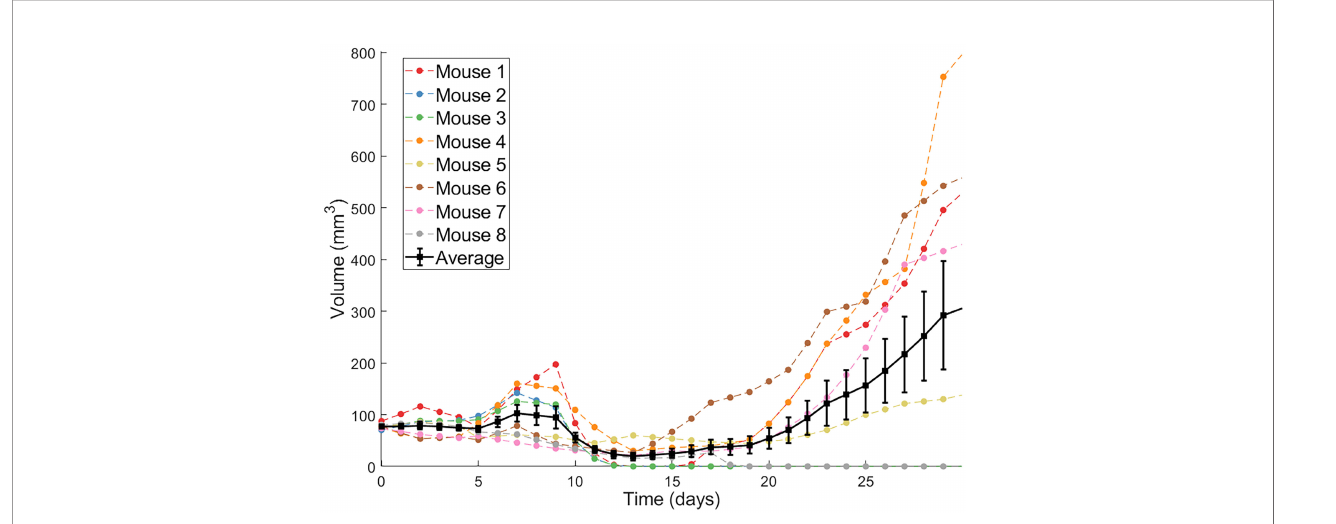
FIGURE 1 | Individual volumetric trajectories are shown for eight mice treated with Ad/4-1BBL/IL-12 (on days 0, 2, 4) + DCs (on days 1, 3, 5). The average, with standard error bars, is also shown in black